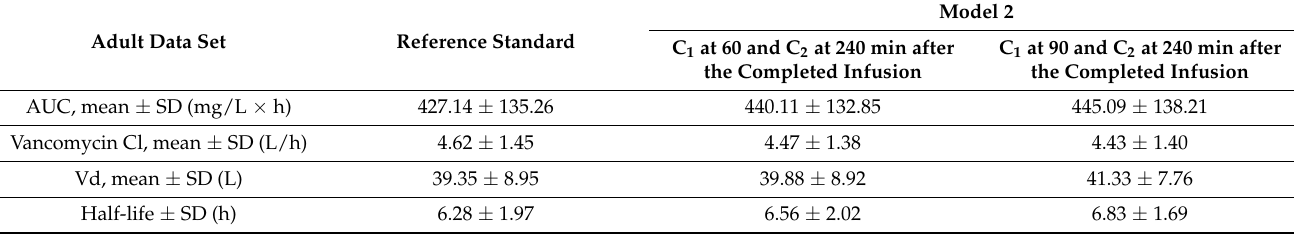
Table 2. Summary of pharmacokinetic parameters of the adult data set derived from selected equation-paired concentration time point combinations compared to the reference standard.